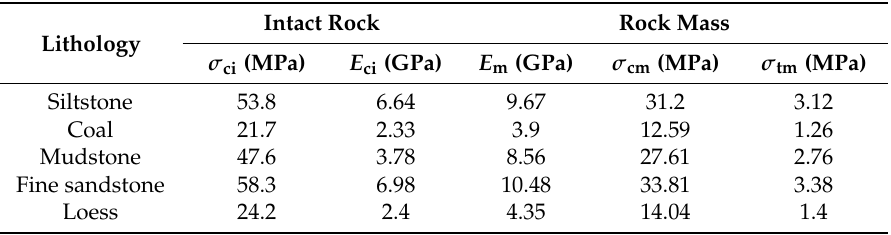
Table 1. Intact rock and calculated rock mass physico-mechanical